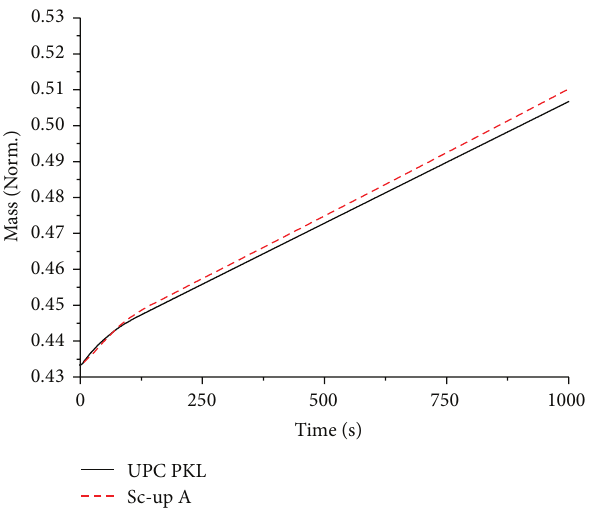
Figure 22: Mass discharged through the break.